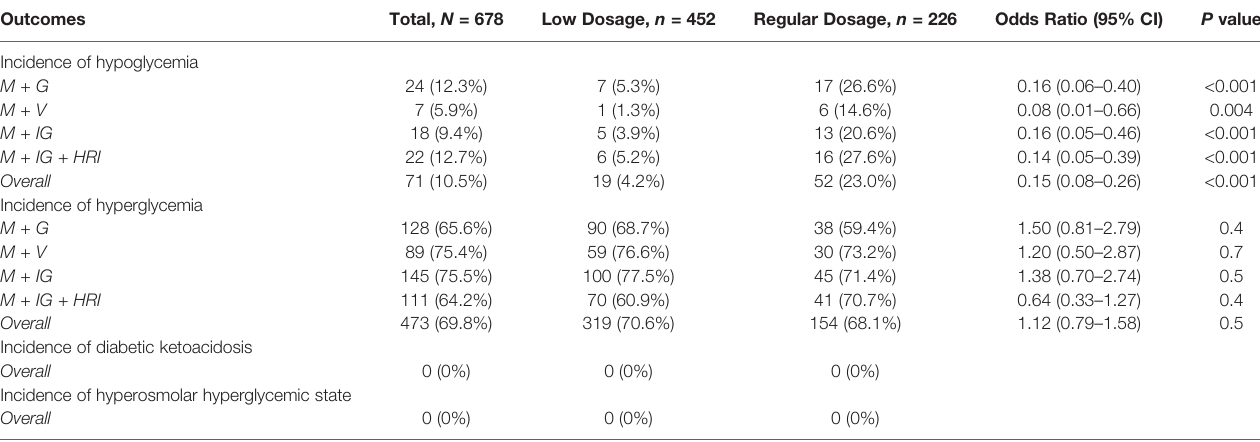
TABLE 3 | Outcomes of the study population ( N = 678 participants). Outcomes Total, N = 678 Low Dosage, n = 452 Regular Dosage, n = 226 Incidence of hypoglycemia M +